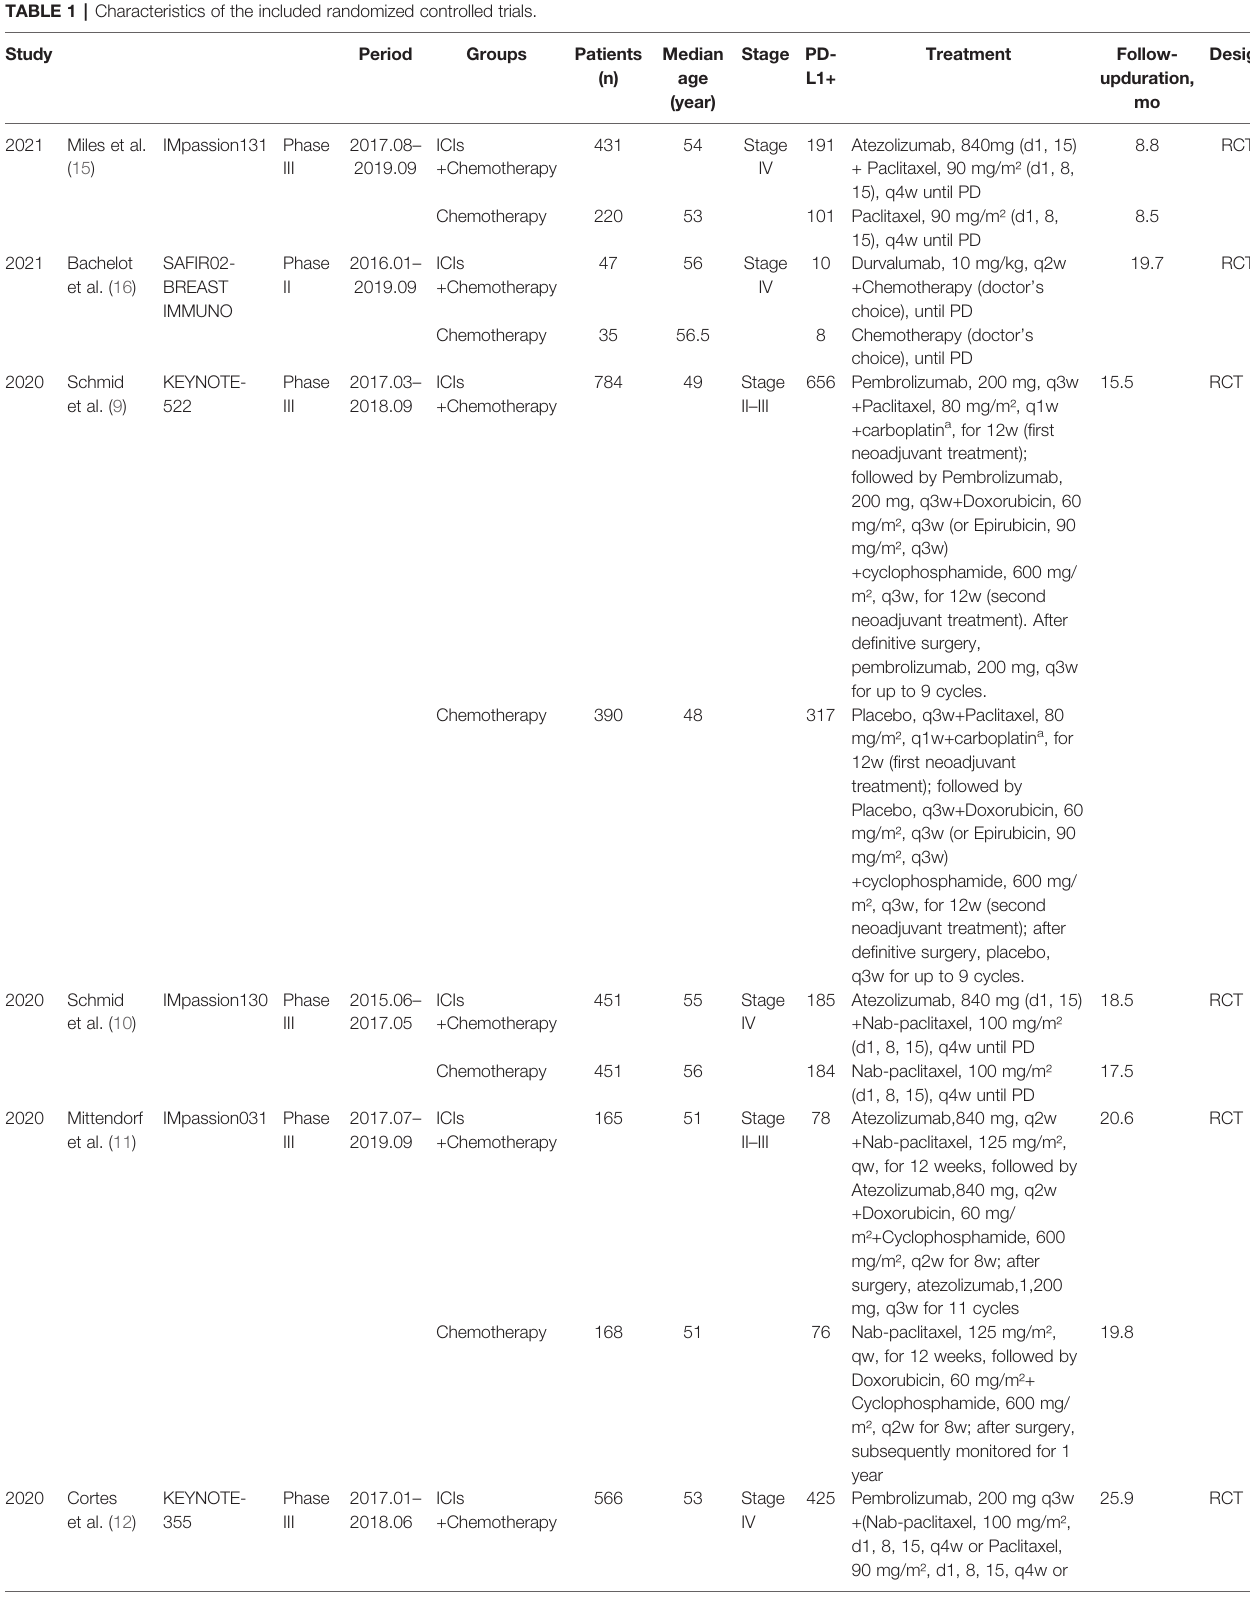
TABLE 1 | Characteristics of the included randomized controlled